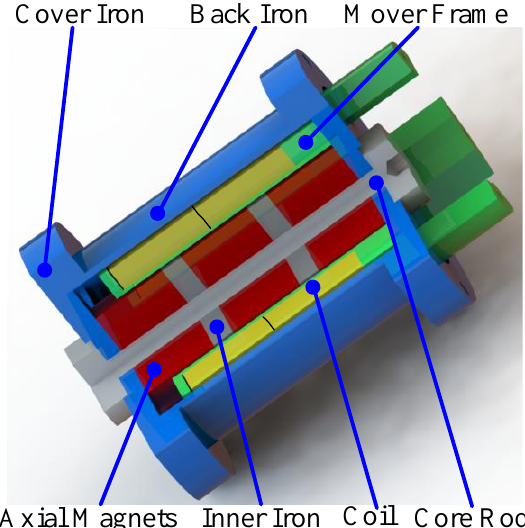
Figure 4. Three-dimensional (3D) structure of the VCM.